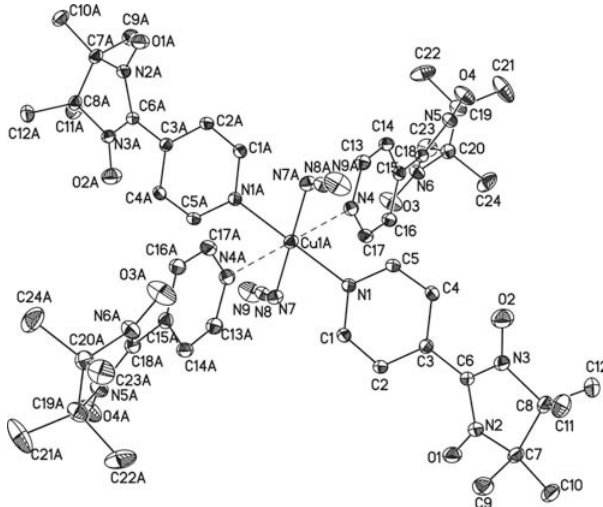
Table 1. Data collection and handling.